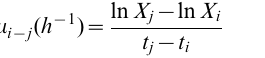
Table S2 Chemical composition of OECD TG